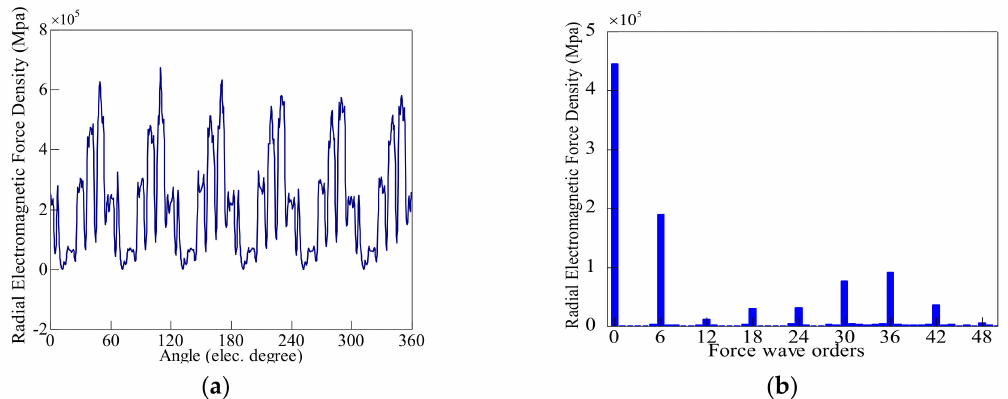
Figure 5. Waveform and harmonic analysis of spatial electromagnetic force density; ( a ) Spatial electromagnetic force density; ( b ) Spectrum